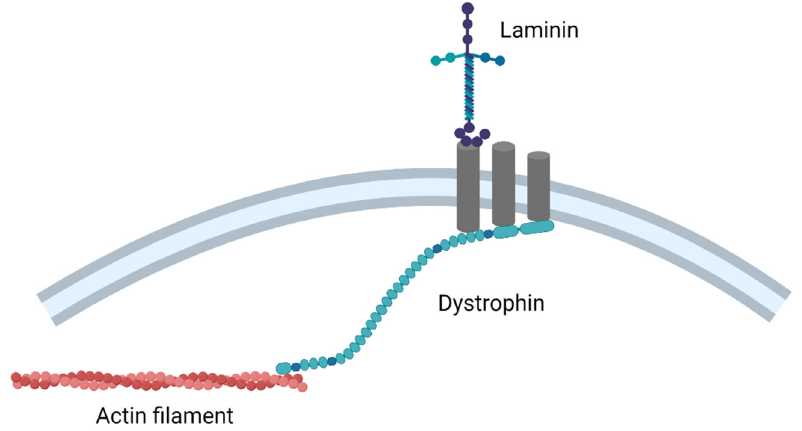
Figure 2. Figure 2. The dystrophin–glycoprotein complex (created with BioRender.com (accessed on 28 Oc- tober 2021)).